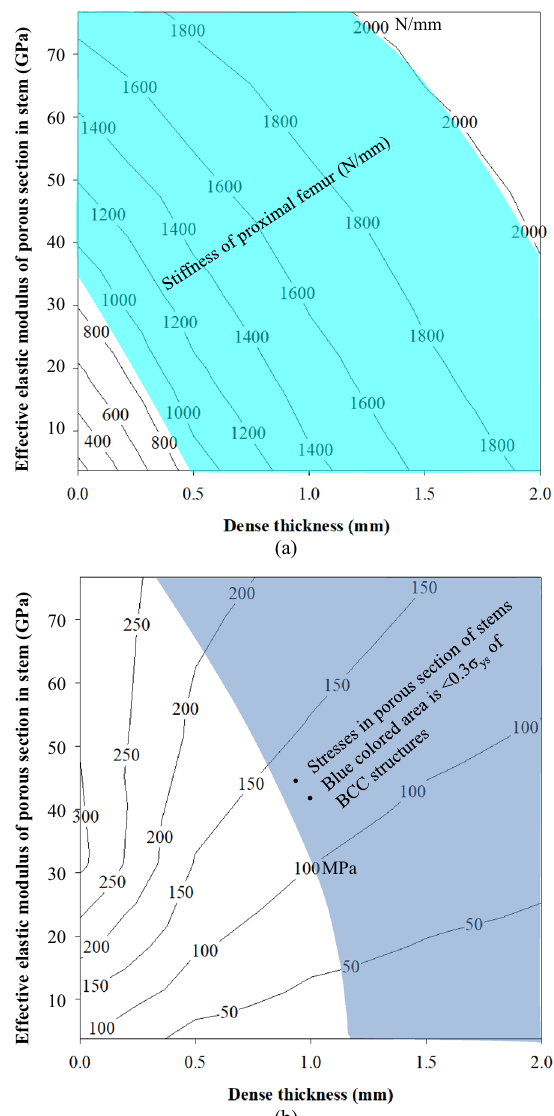
Fig. 4 Results of stiffness and stresses in porous stems; a stiffness of the stem matches to the bone represented cyan shaded area; b 0.3 σ ys stresses in porous section of stems represented blue shaded area (Color fi gure